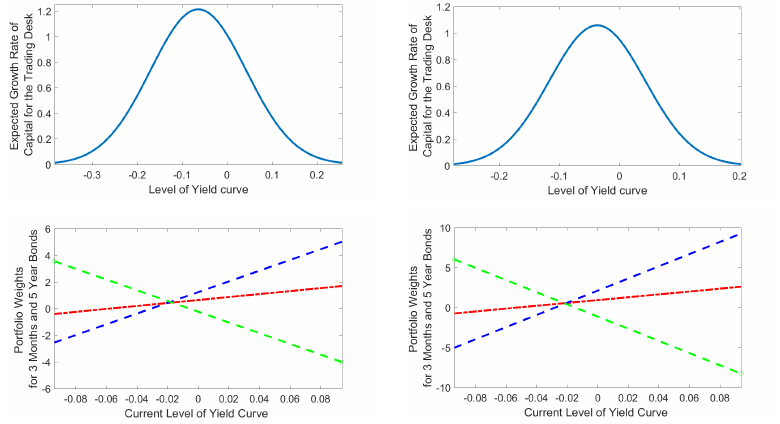
Figure 5. Gross Rate of Return for the Trading Desk Manager’s Capital, γ j = 10 (LHG) and γ j = 5